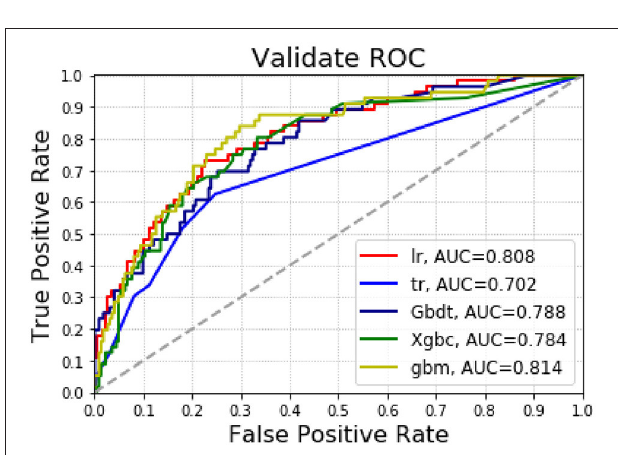
FIGURE 4 | The AUC for predicting pulmonary complications using various machine learning algorithms in the test